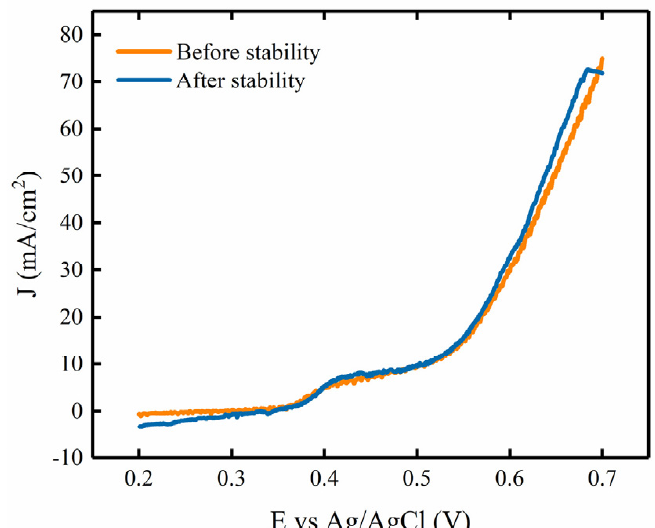
Fig. 8. The LSV curves of the NiO nanoparticles fabricated at 400 °C in 1 M NaOH electrolyte before and after the six-hour chronoamperometric test. The measurements were done at the scan rate of 2 mV/s.